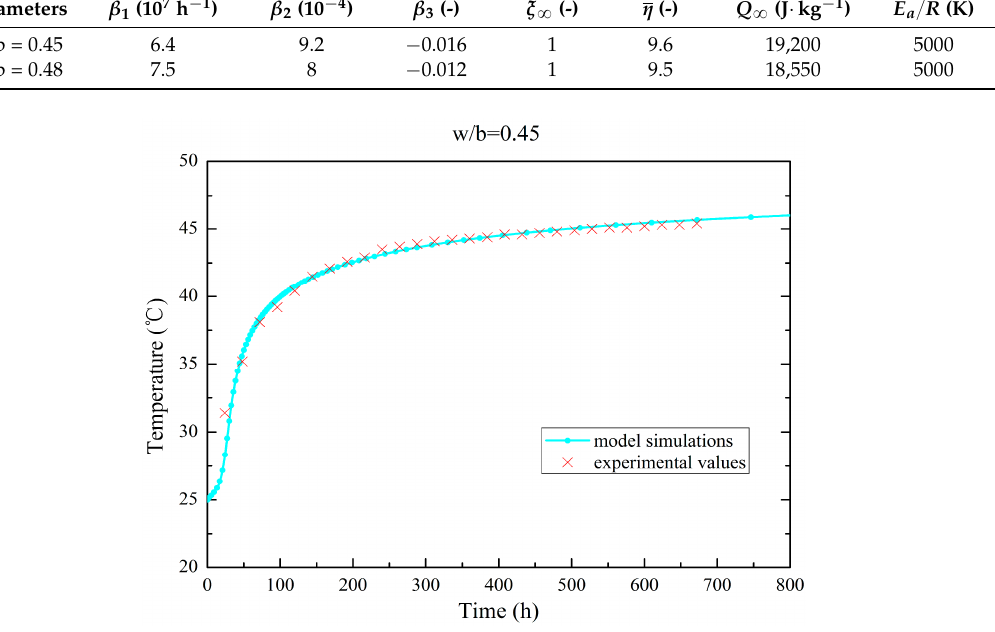
Figure 1. Temperature evolution for adiabatic test of fly ash concrete (w/b = 0.45).